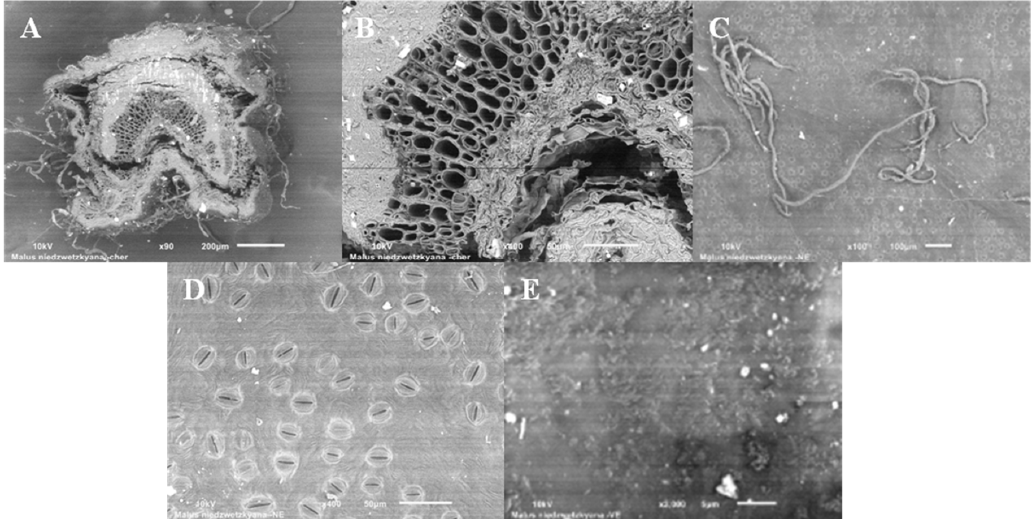
Figure 3. Malus niedzwetzkyana Borkh.: A – transverse sections of the petiole; B – parenchyma cell transverse sections of the petiole; C ---- lower epidermis, trichomes; D – lower epidermis, stoma; E – upper epidermis, epicuticular waxes